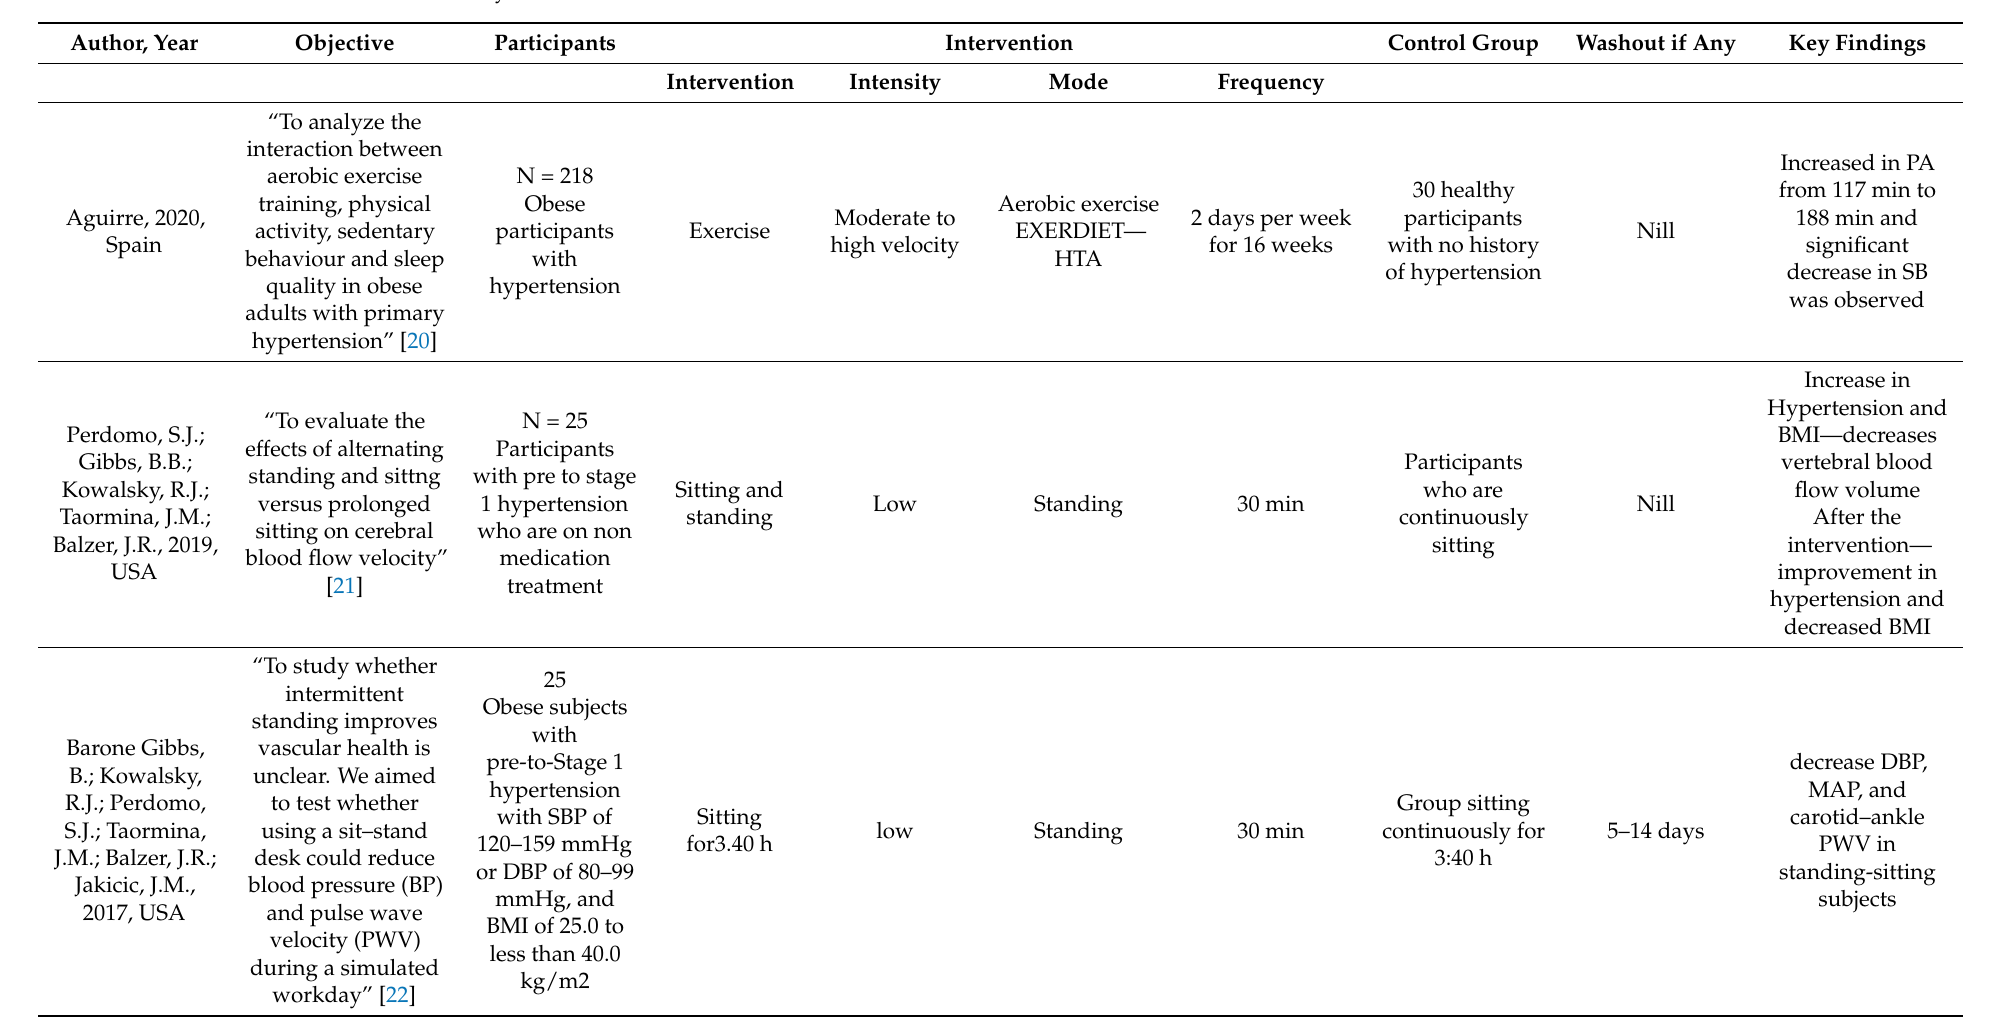
Table 3. Study classification and its